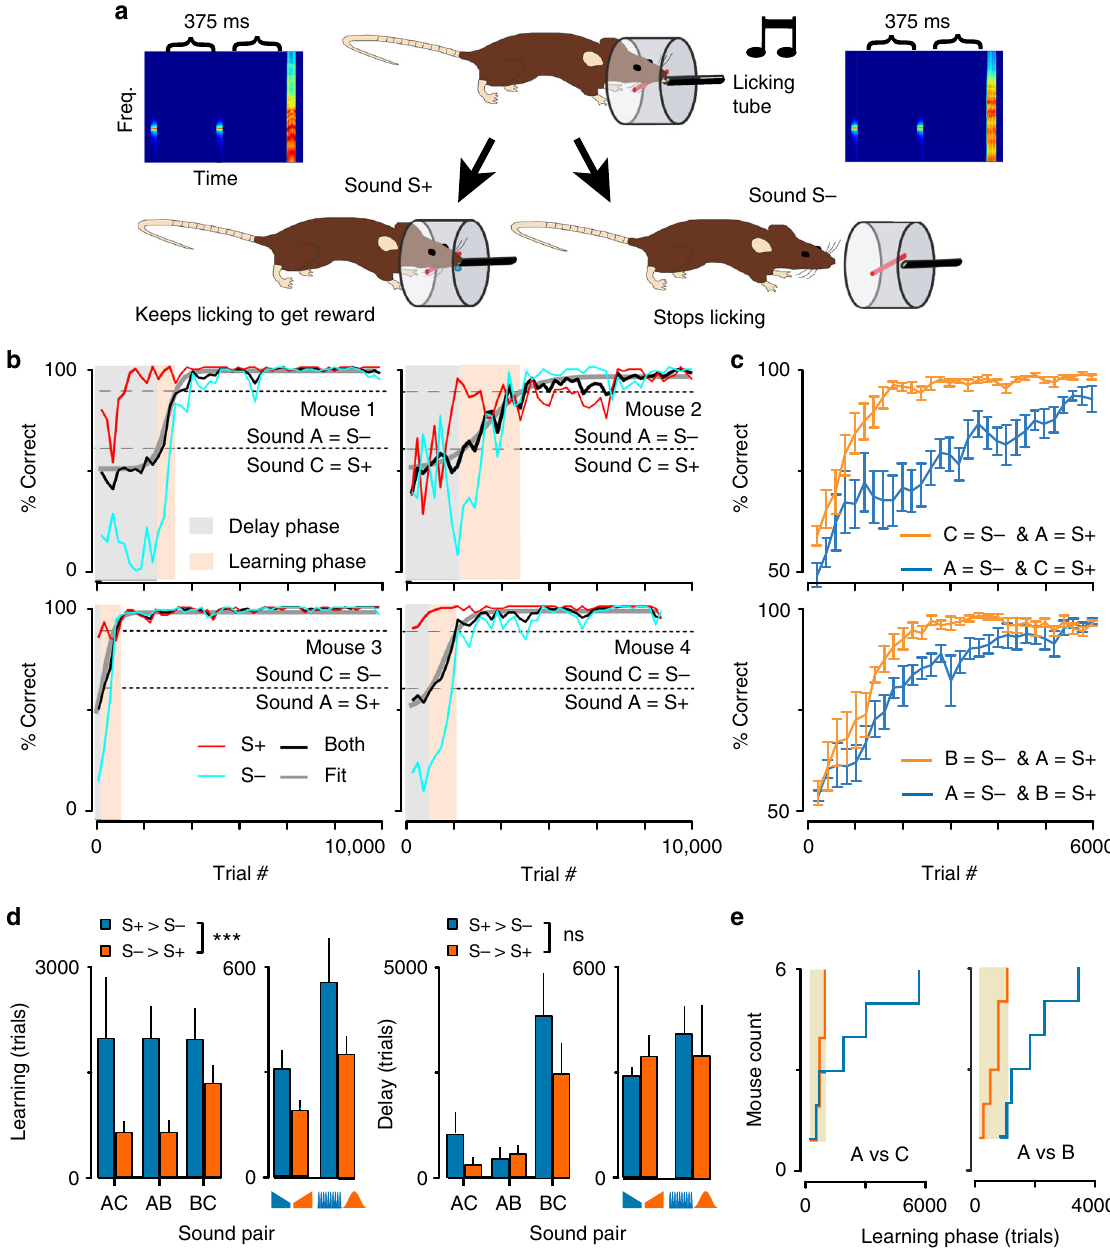
Fig. 3 Cortical recruitment differences impacts learning phase duration. a Schematics describing the auditory Go/NoGo discrimination task. b Individual learning curves for four mice discriminating sounds A and C. Performance for S + (red), S − (light blue) and both (black) sounds are displayed. Mice from the top row have sound A as the S − stimulus while mice from the bottom row have sound C as the S − stimulus. Typical learning curves display a delay and learning phase as shown in light gray and orange colors. c Mean learning curves for different groups of mice ( n = 6 for each curve) discriminating between sounds A and C (top) or A and B (bottom). Slower learning is observed when the S − sound recruits less cortical activity than the S + sound (blue) as compared to when sound valence is swapped (orange). d Mean±standard error for the learning and delay phase for the fi ve discriminated sound pairs (A vs C, A vs B, B vs C, up- vs down ramp, 20Hz vs 1Hz modulation represented by blue and orange symbols). The conditions “ S − recruitment >S + recruitment ” (blue) and “ S + recruitment <S − recruitment ” (orange) are signi fi cantly different for the learning phase but not the delay phase (Friedman test, p = 0.0005 indicated as *** and p = 0.72 indicated as ns, n = 6 mice per group except for the up- and down ramps, n = 12). e Cumulative distributions of learning phase durations for sound pairs A – C and A – B. Error bars represent standard errors